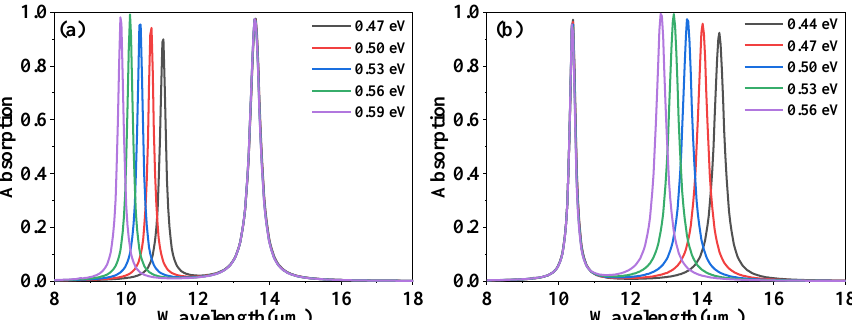
Figure 6. The absorption spectra of the designed absorber with Fermi levels for ( a ) E F1 of the upper graphene nanodisk and ( b ) E F2 of the lower graphene nanodisk.